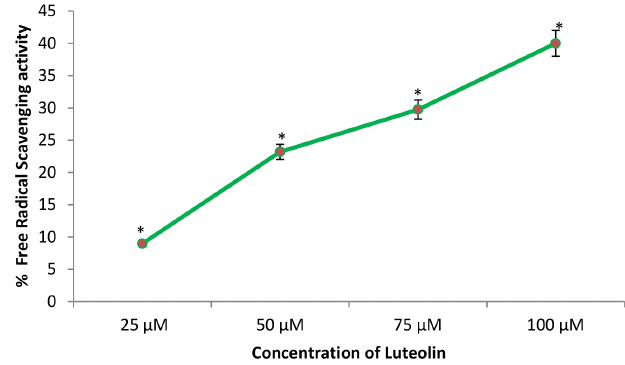
FIGURE 2S - Free radical scavenging activity of luteolin. The values are the mean of five assays [*significant with respect to control,